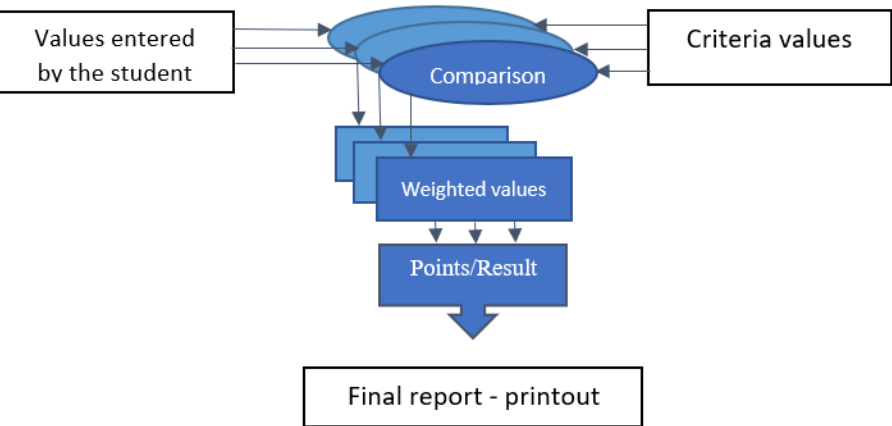
Figure 4. Simplified scheme of the SEA application operation (based on Cross, S.J., 1996) [20]. The SEA system provides the possibility of assessment at two levels: basic and